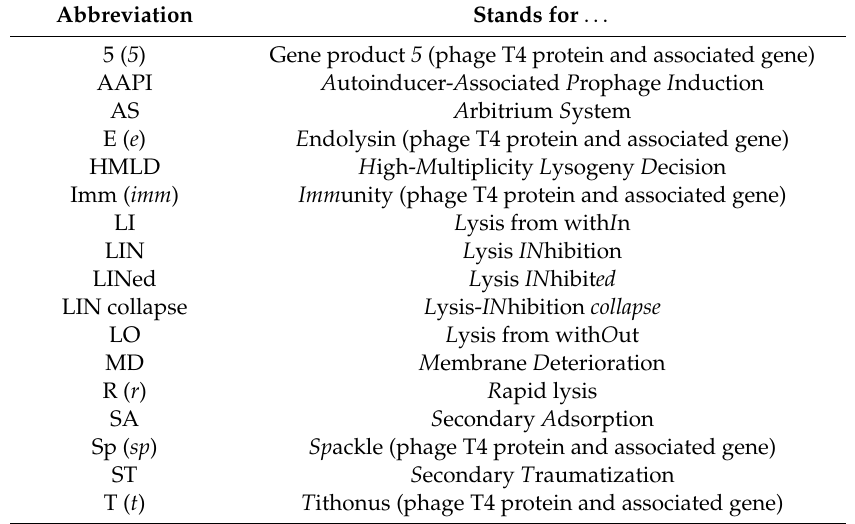
Table 1. Abbreviations used (see Table 2 for fuller definitions).